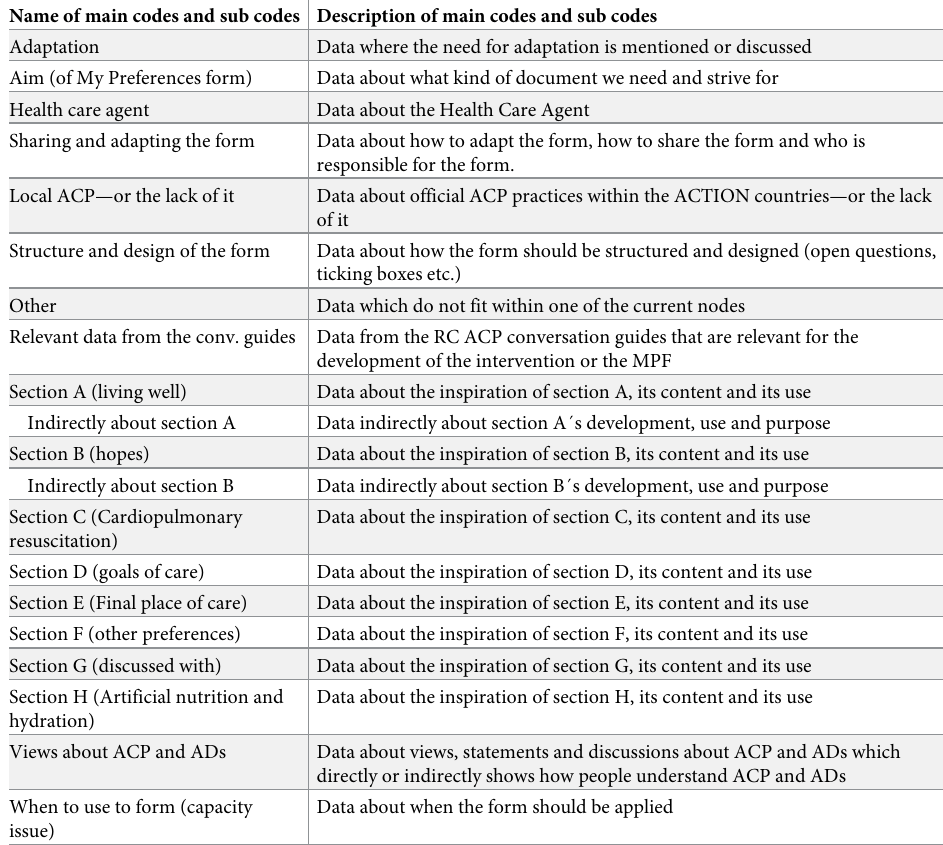
Table 4. The final coding